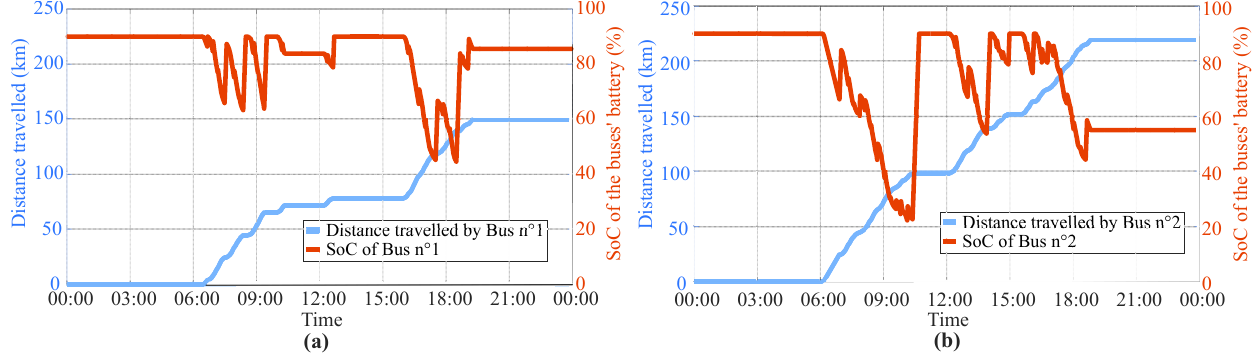
Figure 13. Travelled distance and battery SoC of buses n°1 ( a ) and n°2 ( b )—scenario 3. Concerning the charging power, Figure 14 shows that most charges occur at different times with a power of 150 kW (the rated power of one charger). Rarely, 2 buses are charging at the same time, with a cumulative power of 300 kW when both buses are at bus stops (but not necessarily the same stop). The assumption here is that all chargers are connected to the same substation on the utility grid. Otherwise, the technical constraints would differ for each portion of the network where the chargers are located. Regarding PV energy, charging during the daylight at terminals and stops increases the PV self-consumption compared to scenarios 1 and 2. Additional storage would increase the PV benefits. Considering the reasonable amount of energy needed as the next charging station is close and the high charging power required due to the short duration of charges at bus stops, supercapacitors with a high power density could be used to store the solar energy but with an increased